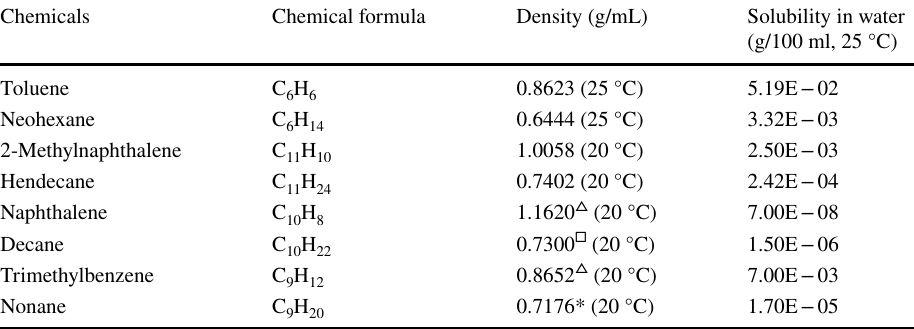
Data without any symbol from Haynes (2016); Data with the triangle symbol ( △ ) from “Hazardous Sub- stances Data Bank” which obtained from the National Library of Medicine (US); Date with the square symbol ( □ ) from Fengjun et al. (2008); Date with the star symbol (*) from Kirss et al.